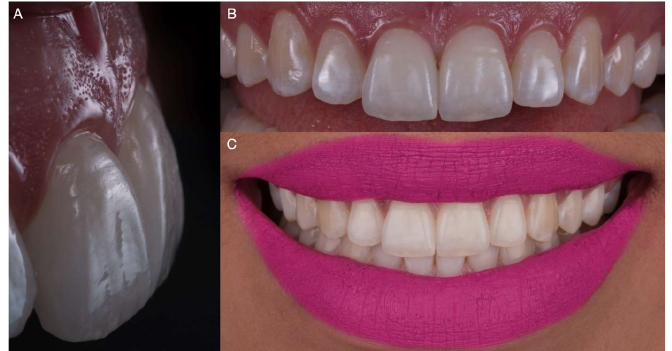
Figure 8. Clinical appearance of the installed bonded laminate veneers. ( A ) Lateral view. ( B ) Maxil- lary intraoral aspect. ( C ) Extraoral final smile.